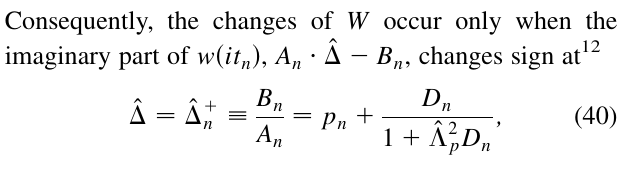
FIG. 2. A typical dependence of the number of growing modes on detuning for an FEL with an energy distribution having two